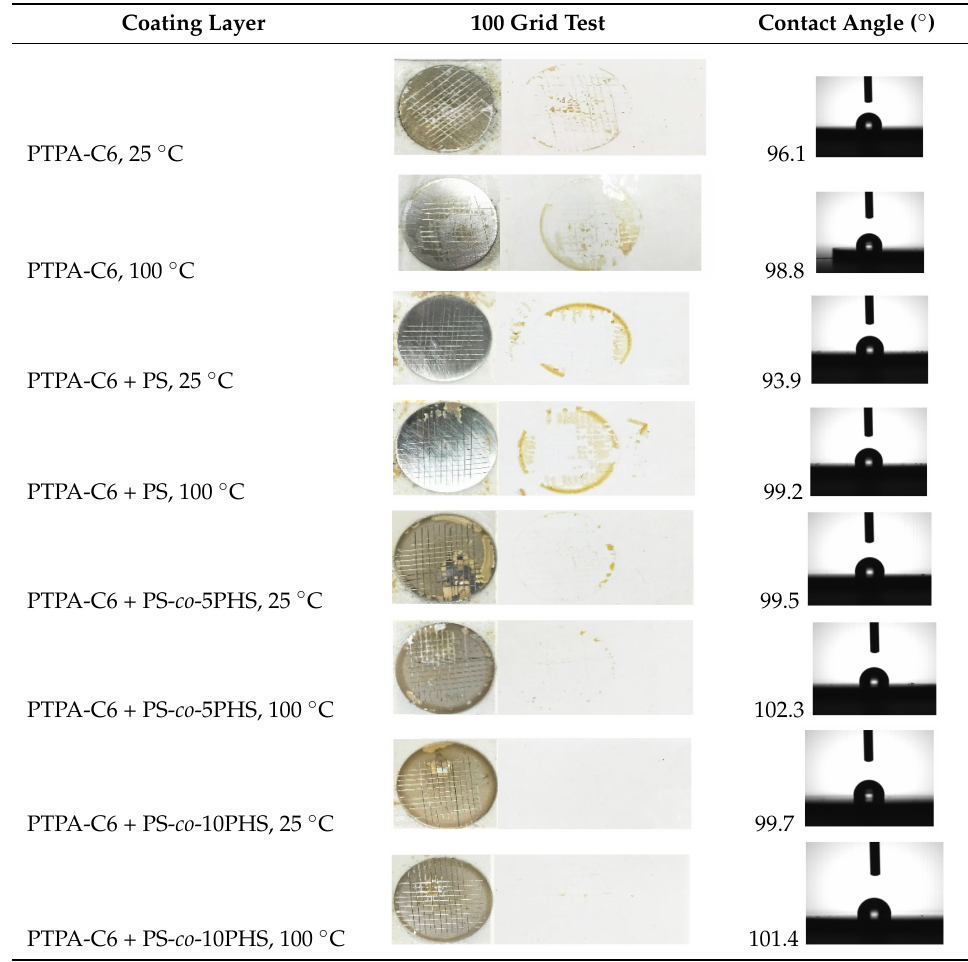
Table 1. Adhesion tests (ASTM 3359) and contact angle measurements of water on PTPA-C6 and its blends at room temperature (25 ◦ C) and under a 100 ◦ C